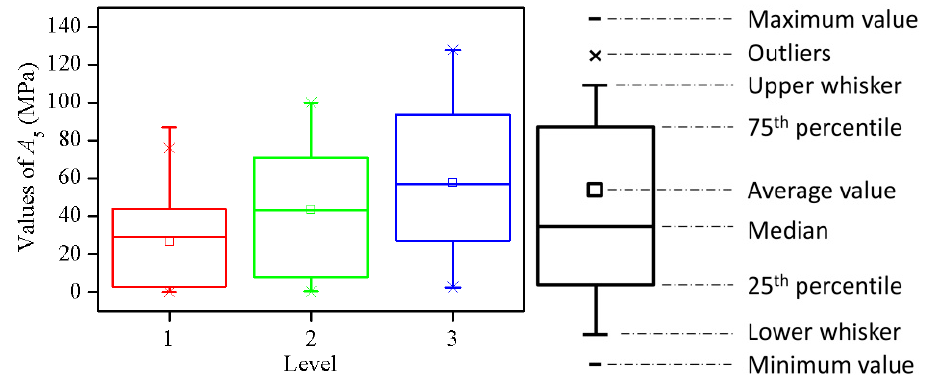
Figure 2. Distribution of pillar stability levels.